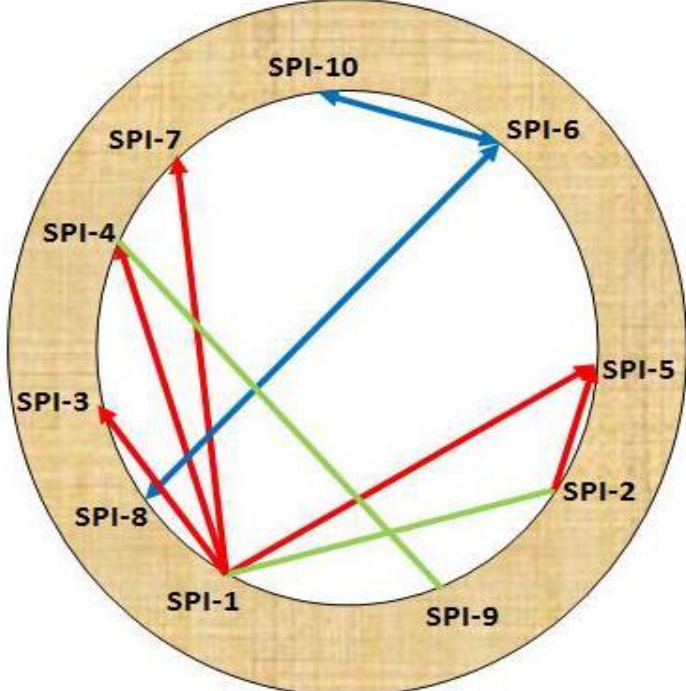
Figure 14: Schematic diagram showing the interdependencies between the 10 SPIs. Single- headed red arrow indicates that function of one SPI region (target) depends on the function of another SPI region (regulator). Green line indicates that both have the similar secretion system while double-headed blue arrow indicates that the gene/operon is interrelated between the